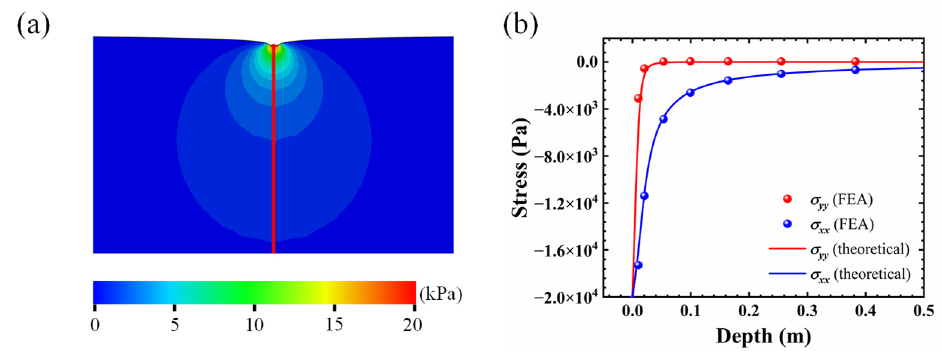
Figure 5. ( a ) The Mises stress distribution from FEA; ( b ) comparisons between theoretical solution and FEA